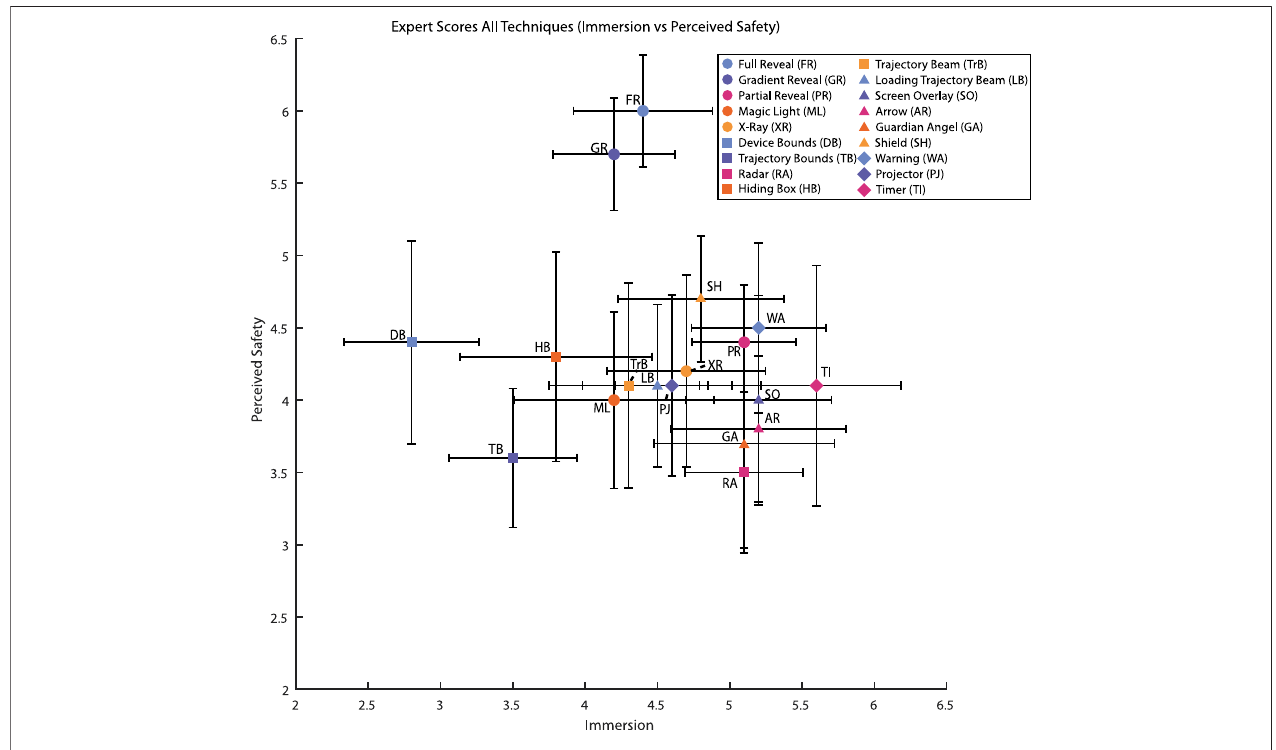
TABLE 2| Theprincipal component analysisfromthequestionnairedata.The fi rst part details the correlations for each criterion. The second part presents the eigenvaluesandthepercentofthevarianceexplainedbytheprincipalcomponent. Finally, the third part shows the correlation between principal components. Criteria